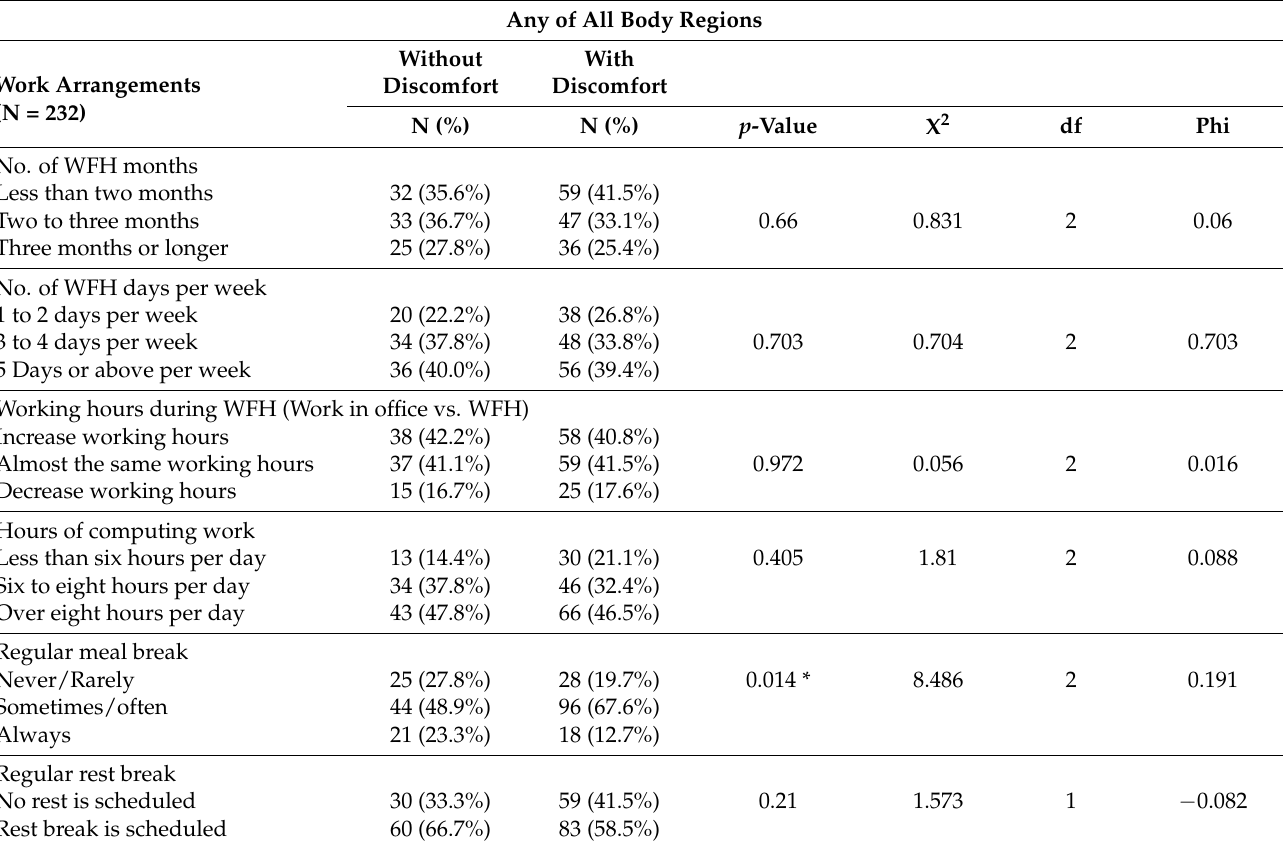
Table A4. The association between work arrangements and with/without musculoskeletal discomfort of any of all body